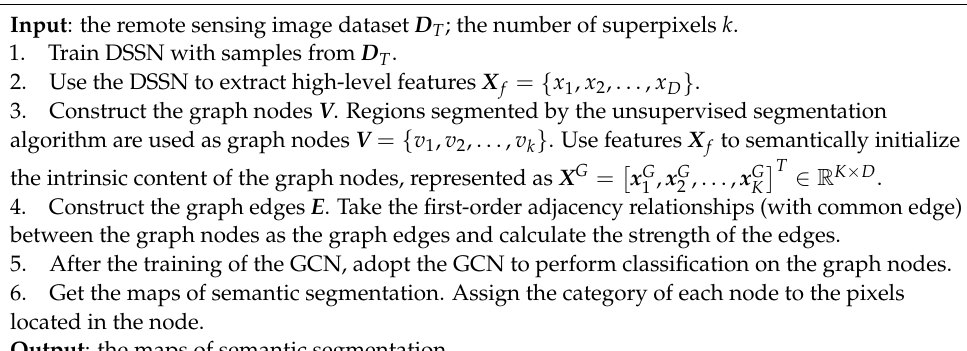
Algorithm 1 . Combining DSSN and GCN for Semantic Segmentation of Remote Sensing